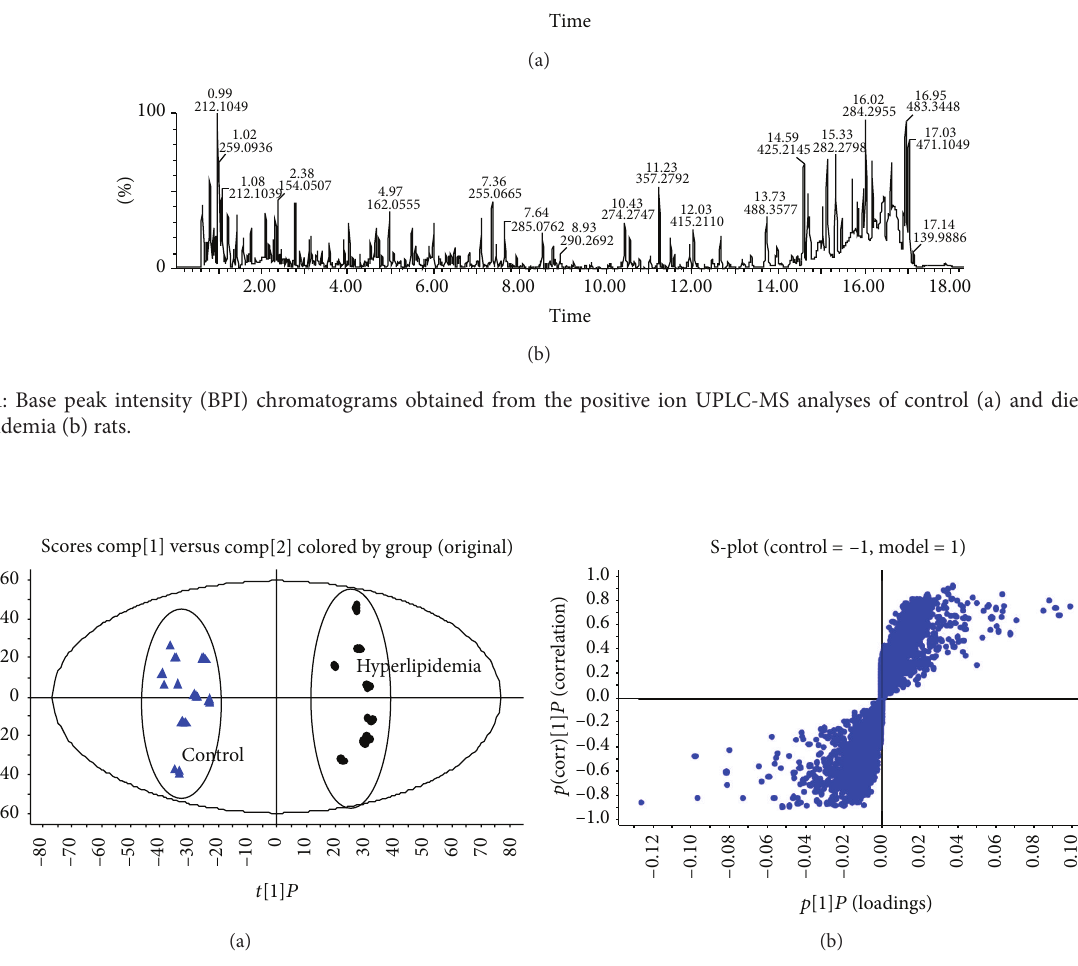
Figure2:(a)OPLS-DAscoreplotbasedontheurinarymetabolicprofilingofthehyperlipidemia( e )andcontrol( 󳵳 )rats;theresultsindicated that the urinary metabolic pattern was significantly changed in the diet-induced hyperlipidemia rats. (b) S-plot used in our biomarkers selection. The variables marked ( ◻ ) are the metabolites selected as potential biomarkers. The significant metabolites were selected as potential biomarkers from S-plot and these urinary metabolites are associated with diet-induced